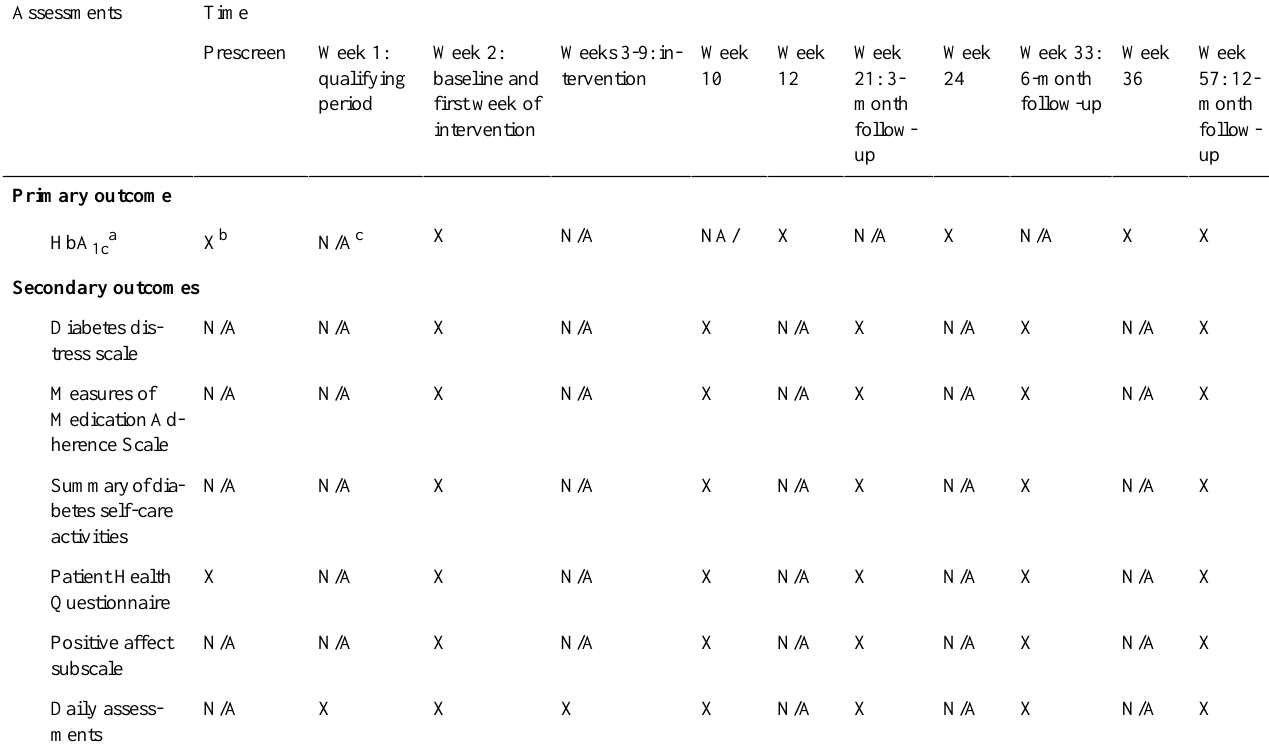
Table 1. Schedule of activities for prescreen, intervention period, and follow-up assessments.